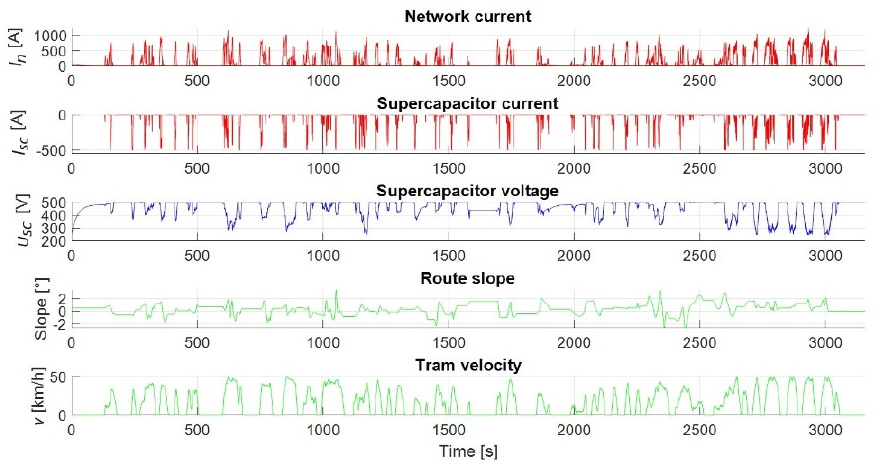
Figure 22. Waveforms during supercapacitor discharging while using the minimum gradient algorithm.